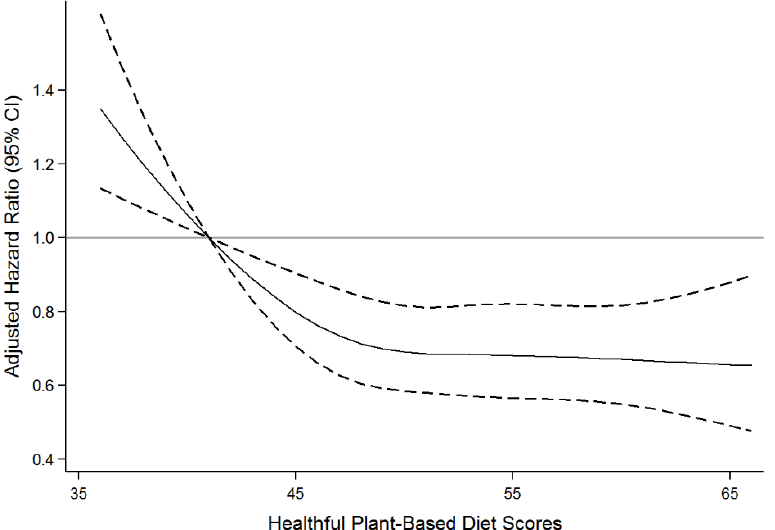
Figure 2. Association of healthful plant-based diet score with incident type 2 diabetes according to the continuous plant-based diet score among the middle-aged and older Korean population. The solid lines represent the multivariable-adjusted hazard ratios for incident type 2 diabetes, modelled using restricted cubic splines with 4 knots (5th, 35th, 65th, and 95th percentiles). The reference was set at the 5th percentile of the score. The dashed lines rep- resent 95% confidence intervals. The model adjusted for age (year, continuous) and sex (men/women), residence area (rural/urban), education (≤6, 7–12, >12 years), physical ac- tivity (MET/day, continuous), cigarette smoking (continuous), alcohol intake (g/day, con- tinuous), baseline body mass index (kg/m 2 , continuous), total energy intake (kcal/day, continuous), family history of diabetes (yes/no), and history of hypertension at baseline (yes/no). Additionally, when we conducted the subgroup analysis stratified by sex, baseline BMI, family history of T2D, and history of hypertension, an inverse relationships between hPDI and T2D risk were stronger in participants with a family history of T2D (HR: 0.58, 95% CI, 0.44 0.76) or history of hypertension (HR: 0.73, 95% CI, 0.60 0.89) than those with- out a family history of T2D ( p interaction = 0.01) or history of hypertension ( p interaction = 0.04). (Table 4)